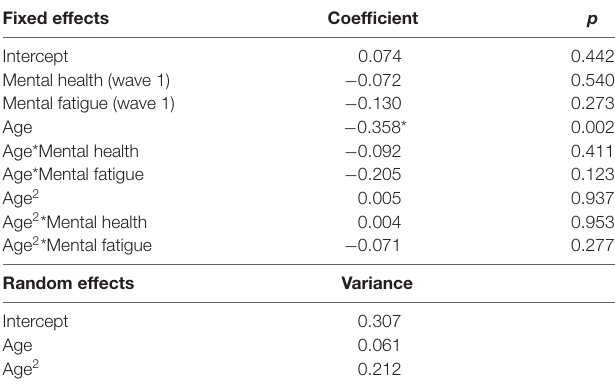
TABLE 3 | Results from multilevel growth curve analyses on cognitive control